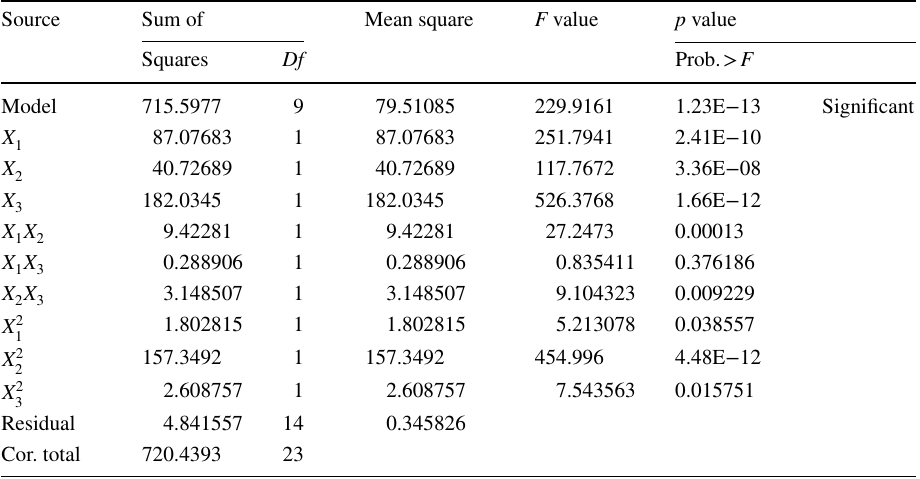
Table 7 Model coefficient for Pb(II) ion removal using AESA